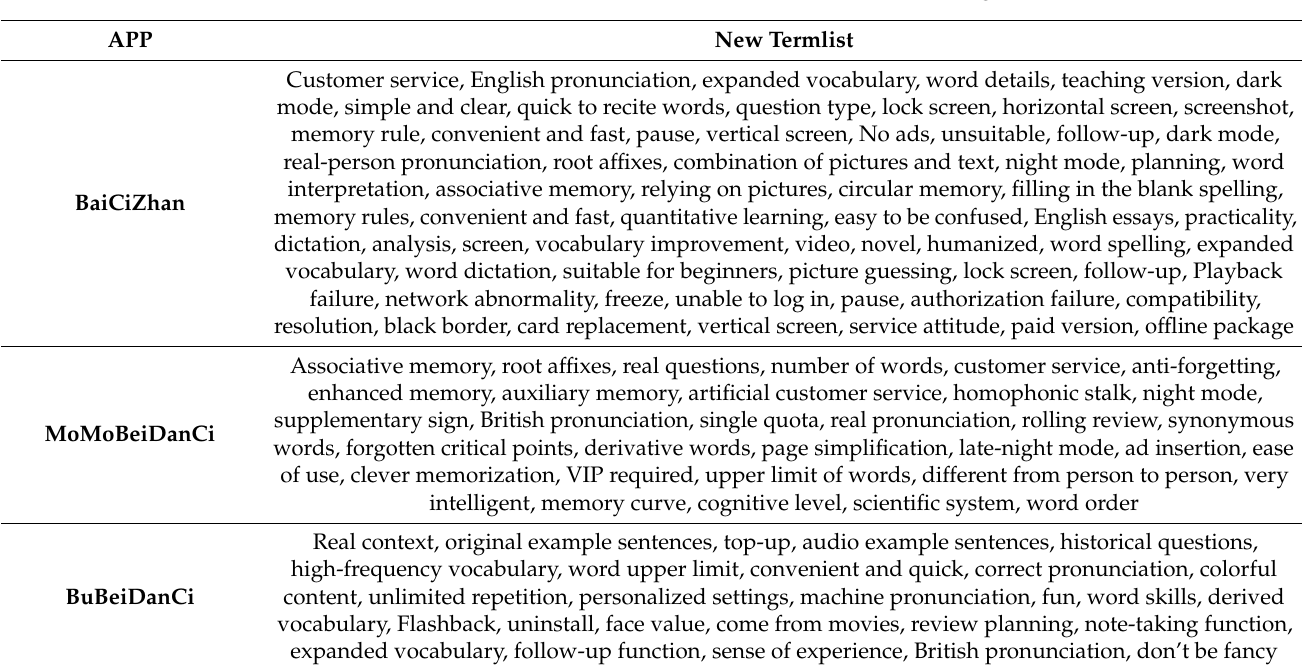
Table 6. BaiCiZhan, MoMoBeiDanCi, BuBeiDanCi new word